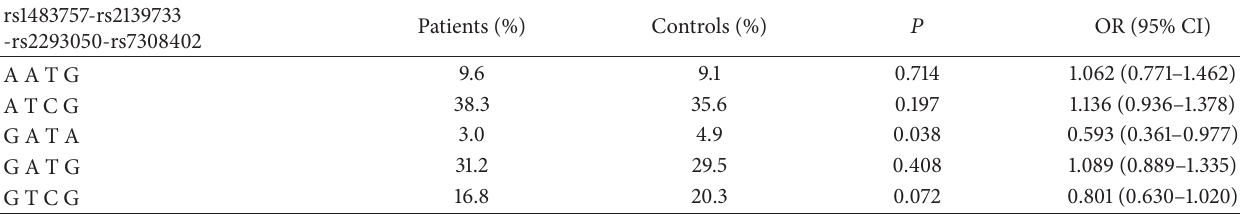
Table 5: Haplotype frequency of NOS1 gene in patients and